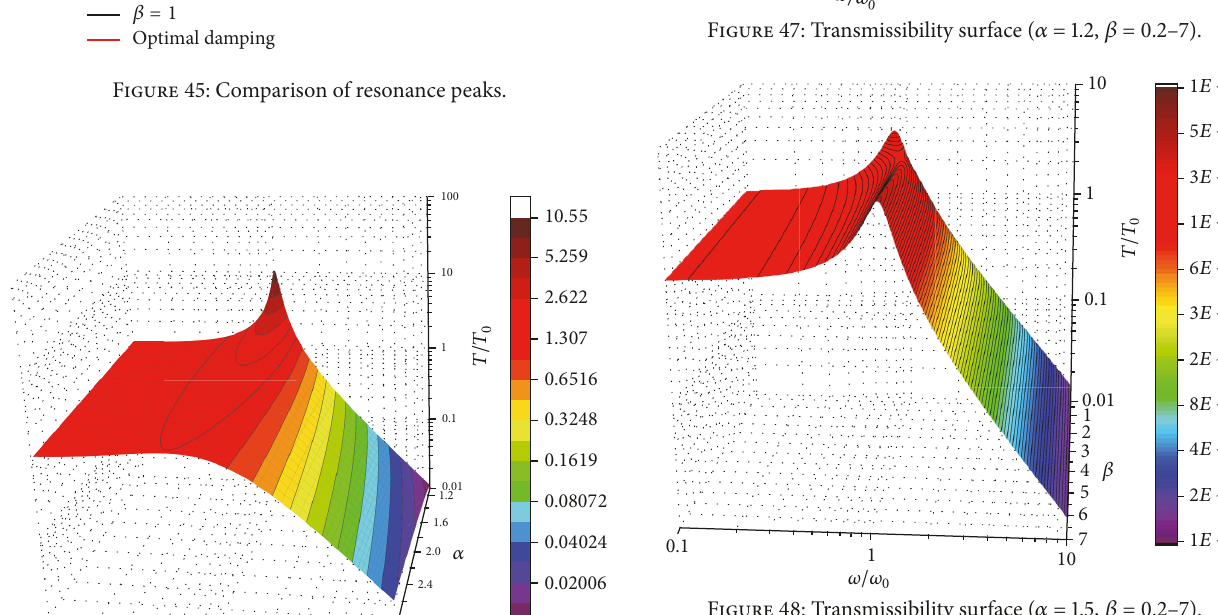
Figure 48: Transmissibility surface ( 𝛼 = 1.5, 𝛽 = 0.2–7).